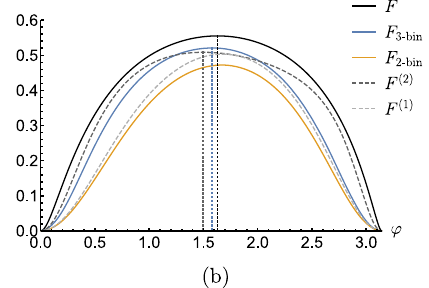
Fig. 7 | FIfor phase θ withimperfect measurements affected by the Poissonian noise. a With binning strategies: the corresponding FI — (cid:2) F 2 (cid:4) bin (orange) and (cid:2) F 3 (cid:4) bin (blue) with optimalbinning into two and three categories, respectively — compared against the exact (cid:2) F ð im Þ (ratio in %) computed by performing large enough cut-off ( x ≤ 100) in Eq. (9). The ratio of means for the Poissonnian distributions is set to λ ∣ = λ ∣ : 65 76 , while λ ∣ 1 i 0 i =0 0 i is varied. The inset shows the absolute values of FIs. b Withbinningstrategiesandthemomentmethod:TheFIs( F – black, F 2-bin – orange,